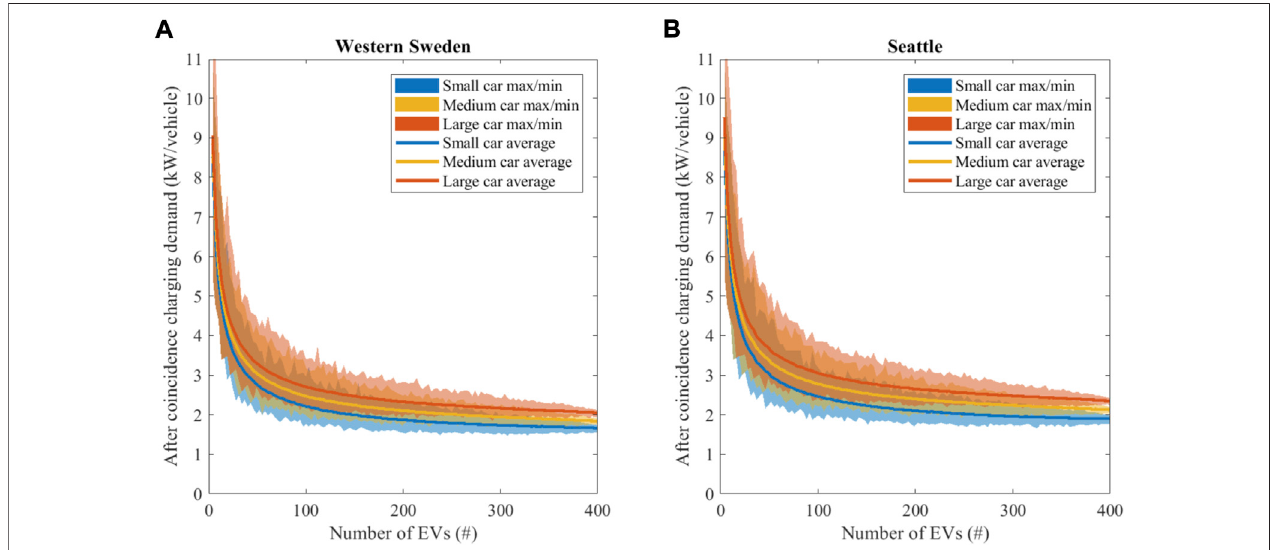
FIGURE 4 | After-coincidence charging power demand for the highest hour of the year and as an average for all combination of vehicles with different driving patterns. After-coincidence charging power demand for three different sized cars. Charging location is home only and nominal charging power is 11 kW. Data for Western Sweden in (A) and Seattle (B) . Shaded areas show variation (max and min) from the randomized